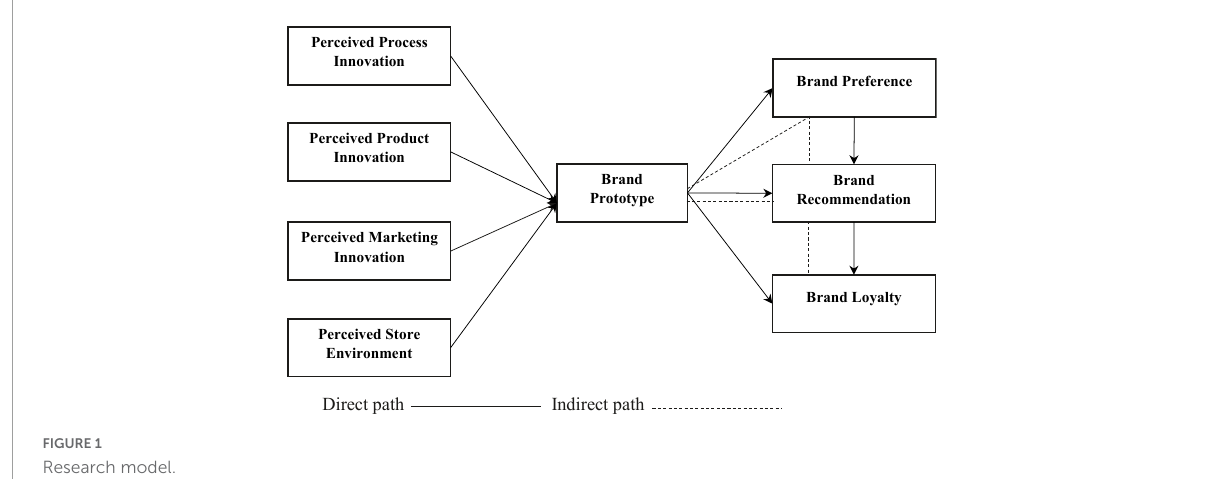
FIGURE1 Research